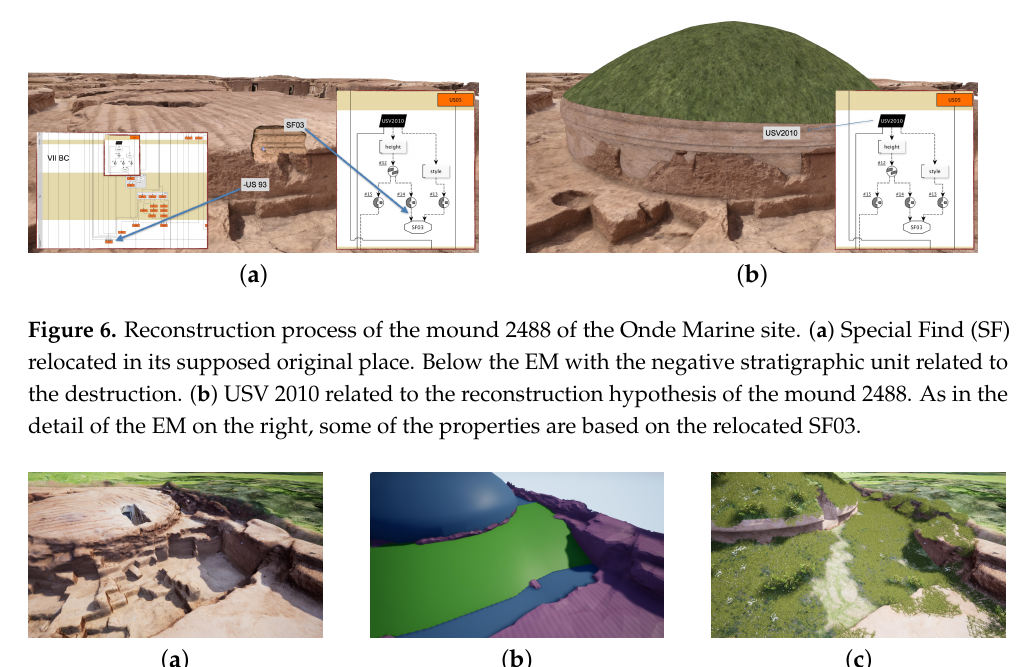
Figure 5. Proxies related to the stratigraphy of the Onde Marine excavation in 2015. On the right the EM representation. The proxies have a color schema based on the epochs they belongs to.